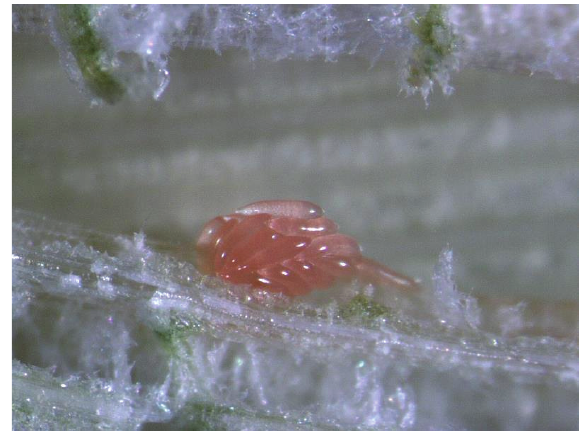
Figure 4: A clutch of eggs in a mesophyll cell of Arundo donax .